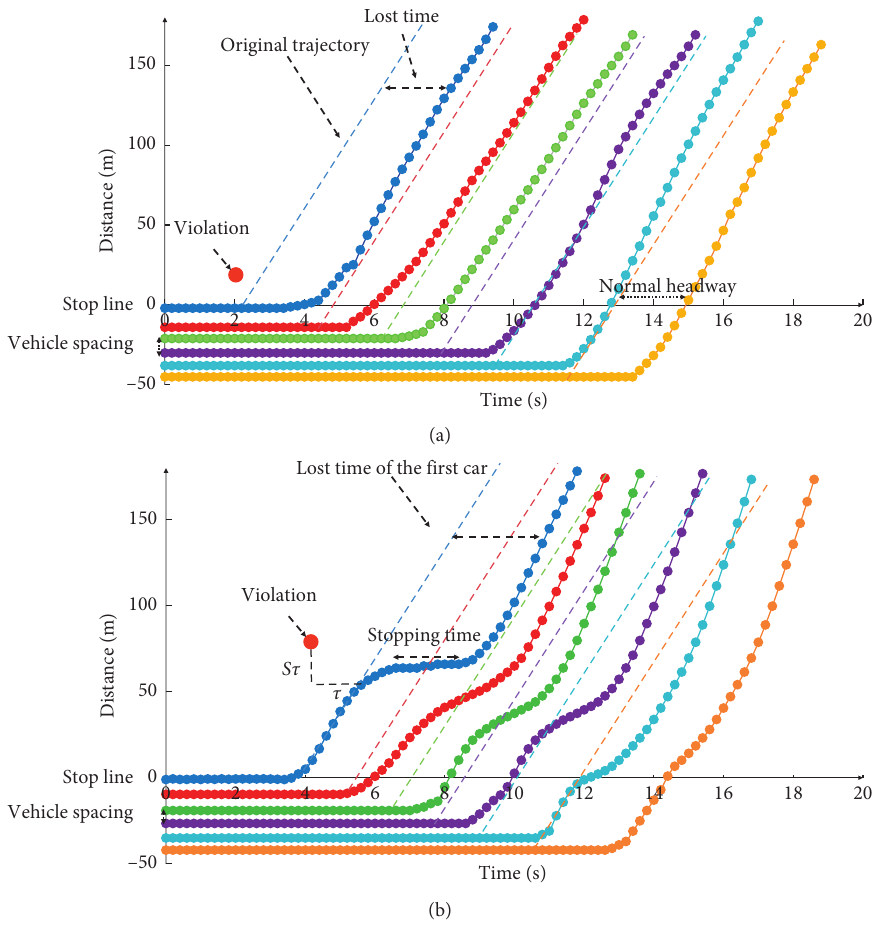
Figure 4: Vehicle trajectories affected by the violation. (a) Idling vehicles. (b) Running